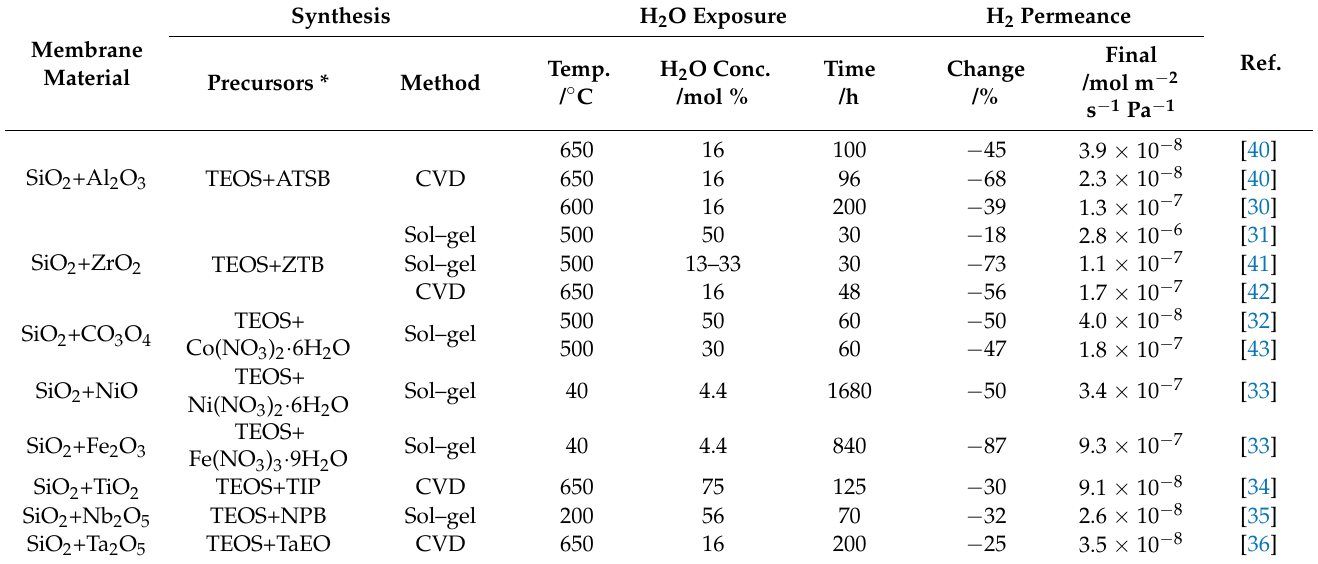
Table 1. Hydrothermal stability of various silica-based composite